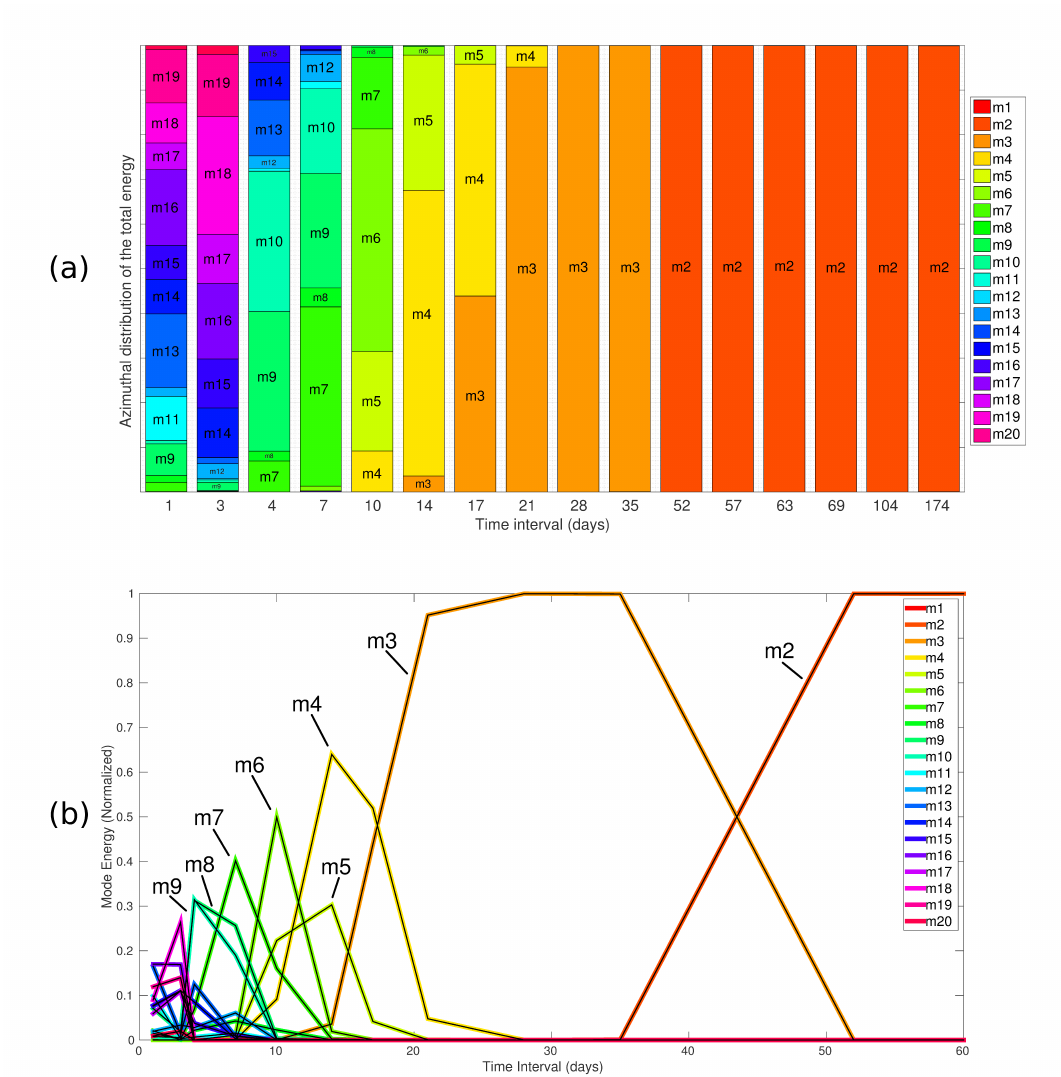
Figure 7. ( a ) Distribution of the perturbation energy on the 20 first azimuthal modes for time intervals ranging from 1 to 174 days. For short time intervals, the spectrum is broad and high wave numbers dominate. As the time interval increases, the spectrum becomes narrower and low azimuthal modes dominate. ( b ) Relative energy of the azimuthal wave numbers against time interval τ . (Energy of each mode normalized by the total energy of the optimal perturbation for each computed time interval). Each azimuthal mode occupies a specific time interval band. High azimuthal modes occupy narrow time interval bands overlapping one another while low azimuthal modes occupy larger time interval